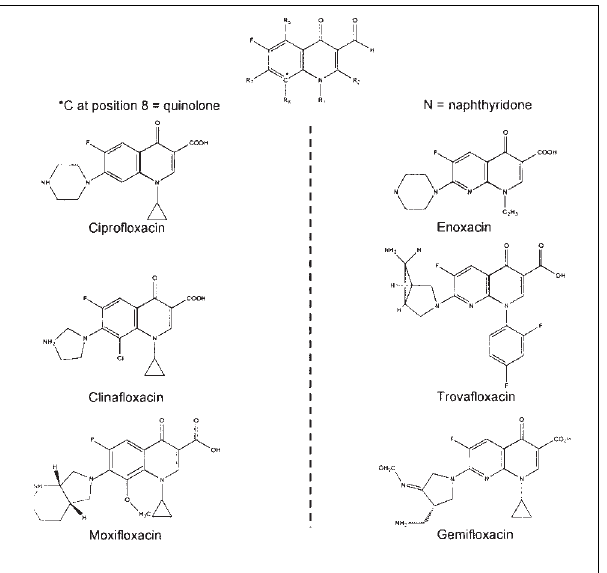
Figure 1) Analogues of the basic fluoroquinolone